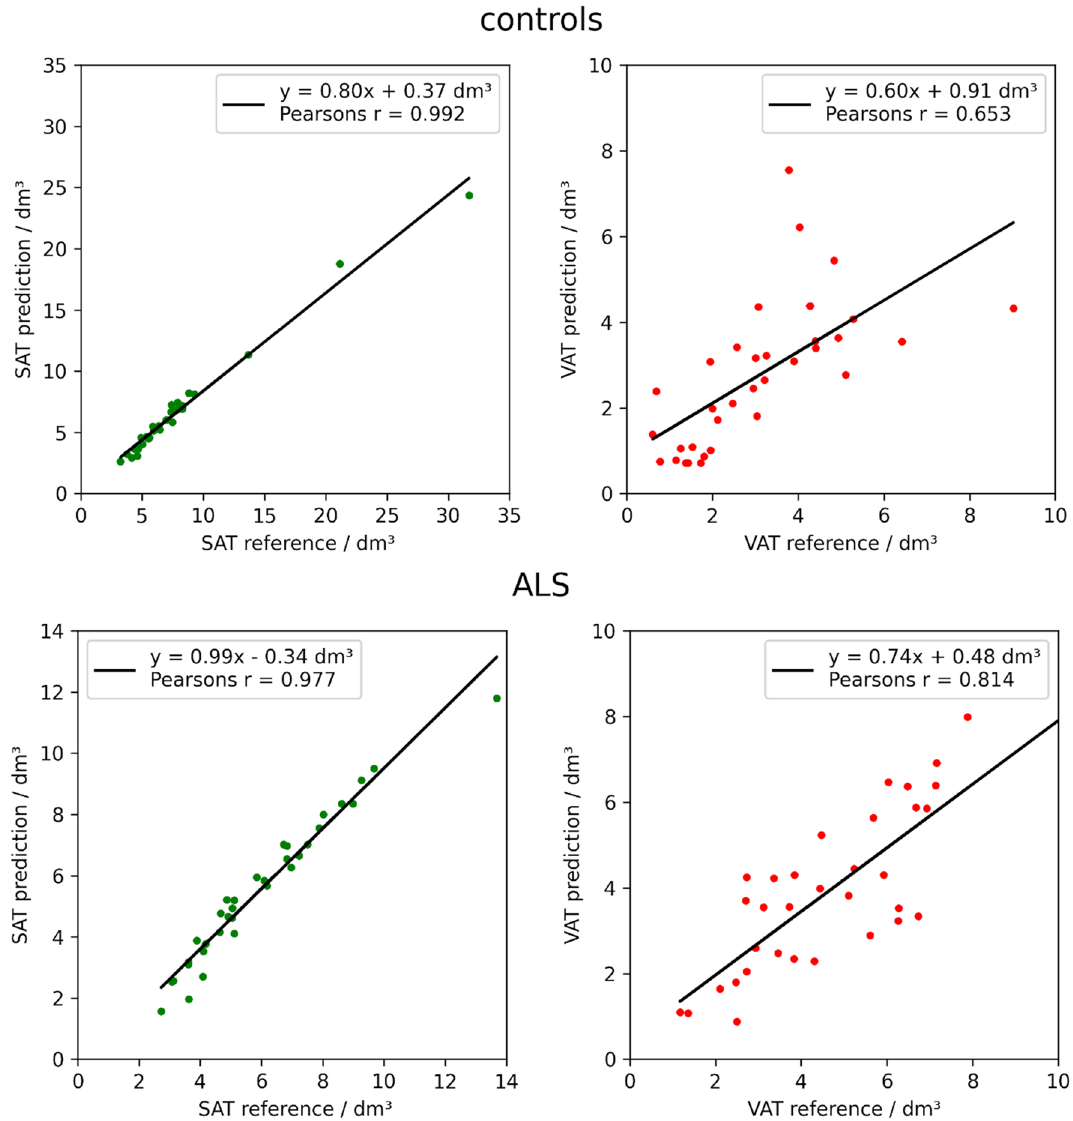
Figure 4. Correlations between volumes of subcutaneous adipose tissue (SAT) and visceral adipose tissue (VAT) calculated based on the reference segmentation vs. predicted by U-Net in the control group (upper panels) and in the ALS group (lower